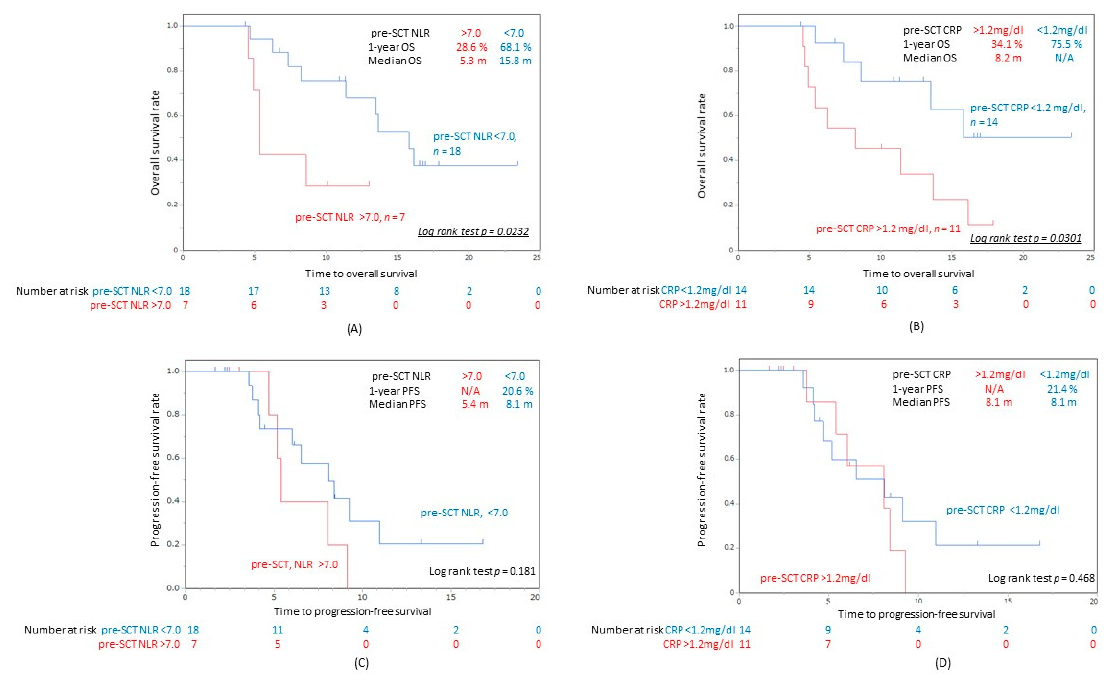
Figure 3. Kaplan-Meier curves for OS ( A , B ) and PFS ( C , D ) in R/M HNSCC patients after PC following the administration of nivolumab. ( A ) OS of patients with pre-SCT NLR > 7.0 and that of patients with pre-SCT NLR < 7.0. ( B ) OS of patients with pre-SCT CRP > 1.2 mg/dL and pre-SCT CRP < 1.2 mg/dL. ( C ) PFS of patients with pre-SCT NLR > 7.0 and that of patients with pre-SCT NLR < 7.0. ( D ) PFS of patients with pre-SCT CRP > 1.2 mg/dL and that of patients with pre-SCT CRP < 1.2 mg/dL. pre-SCT NLR, neutrophil to lymphocyte ratio at the initiation of SCT. CRP, serum C-reactive protein; pre-SCT CRP; CRP value at the initiation of SCT. Table 3. The univariate analysis of factors associated with overall survival and progression-free survival in patients administered salvage chemotherapy with PC.